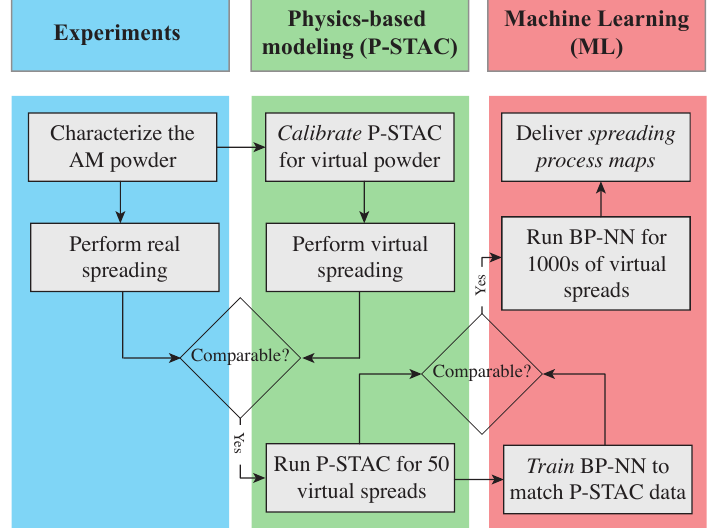
Figure 1. Synergy between experiments, physics-based modeling and physics model-based machine learning enabled surrogate modeling. Reproduced from [36], with permission from the Solid Freeform Fabrication Symposium—An Additive Manufacturing Conference,